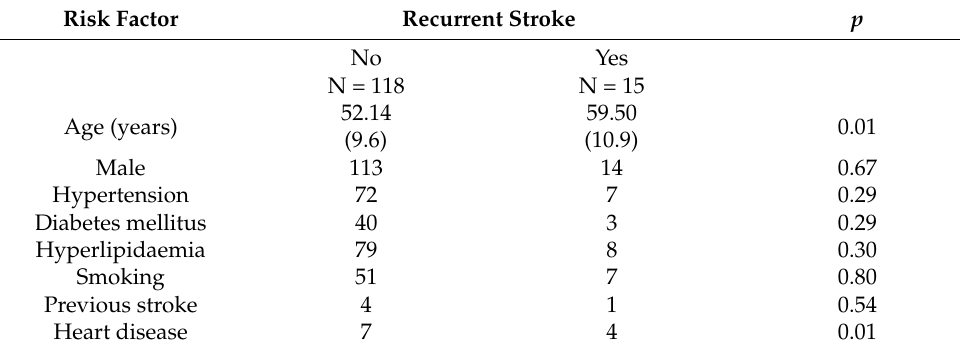
Table 2. Subject risk factors and stroke recurrence.